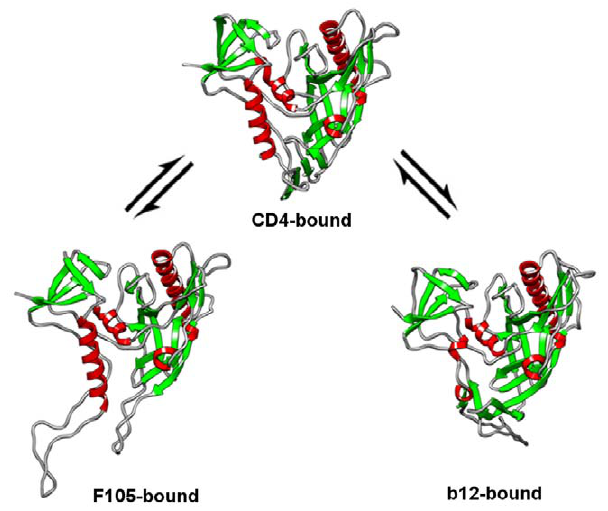
Figure 9. Conformational equilibria between CD4-, F105- and b12-bound conformations of